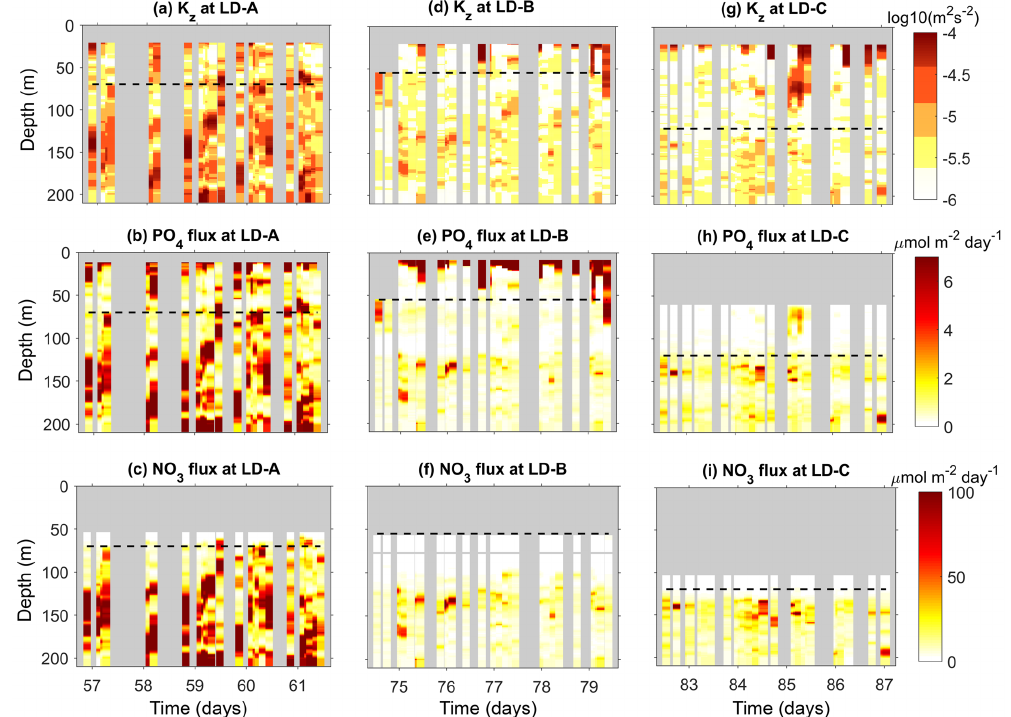
Figure 11. Time–depth sections of K z (a, d, g) , phosphate turbulent diffusive flux (b, e, h) , and nitrate turbulent diffusive flux (c, f, i) . The scales of the color bar of the nitrate and phosphate diffusive flux are set to match with the typical Redfield ratio in the area ( N : P = 16 : 1). The mean euphotic zone depth is displayed with a black dashed line. The top of the nitracline is defined by the isopycnal ρ NO depths of ∼ 83 . 5m at LD-A, ∼ 111 . 2m at LD-B, and ∼ 134 . 6m at LD-C.